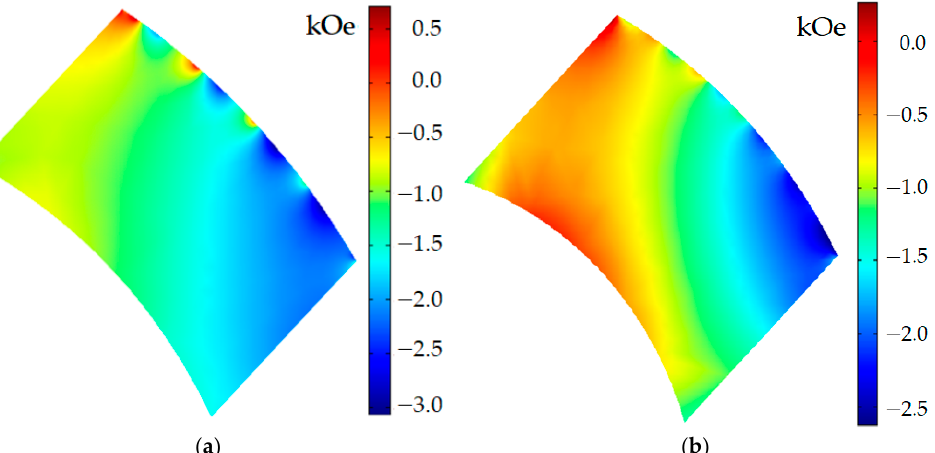
Figure 11. Demagnetizing force (kOe) in the area of the permanent magnet at operating point 4. ( a ) Before optimization; ( b ) After optimization. Table 5. Optimization results.